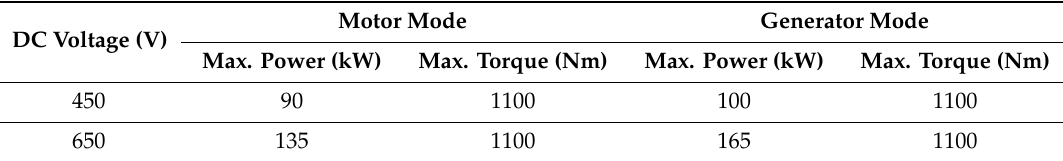
Table 1. The main performance parameters of the traction electric